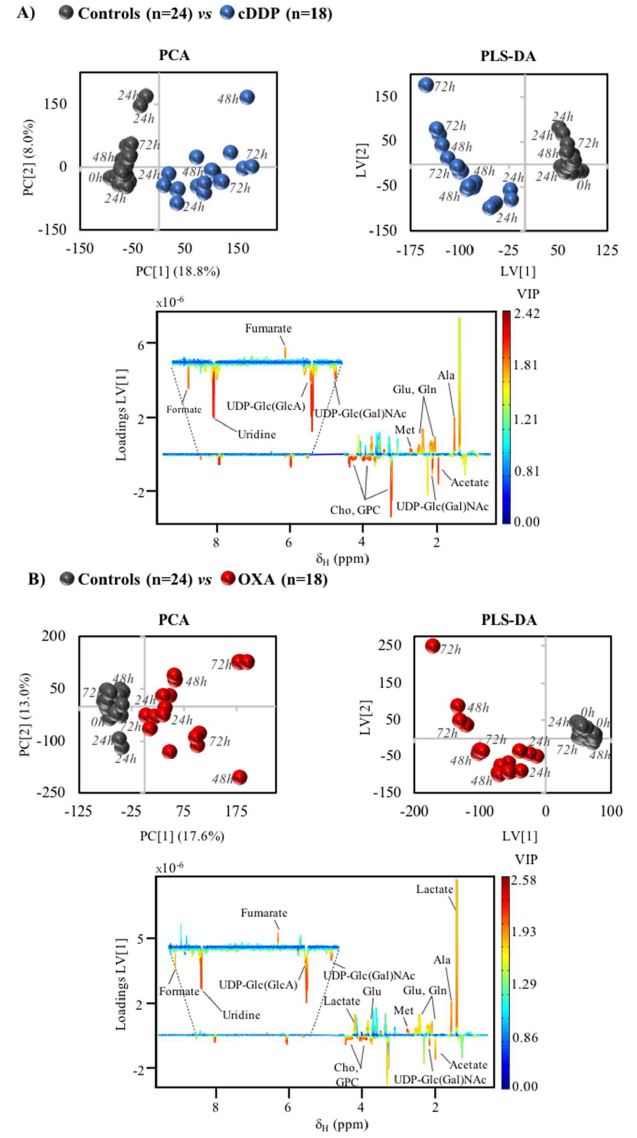
Figure 3. Multivariate analysis of MG-63 cells exposed to cDDP and OXA. ( A ) PCA (left) and PLS- 154 DA (right, with LV = 2, R 2x = 0.259, R 2y = 0.977, Q 2cum = 0.933) scores plots obtained for 1 H NMR 155 spectra of cells exposed to 30 μM cDDP, along with LV1 loadings plot (bottom) colored by variable 156 importance projection (VIP) and with main peak assignments; ( B ) PCA (left) and PLS-DA (right, 157 with LV = 2, R 2x = 0.285, R 2y = 0.954, Q 2cum = 0.884) scores plots obtained for 100 μM OXA, along 158 with corresponding LV1 loadings plot (bottom).